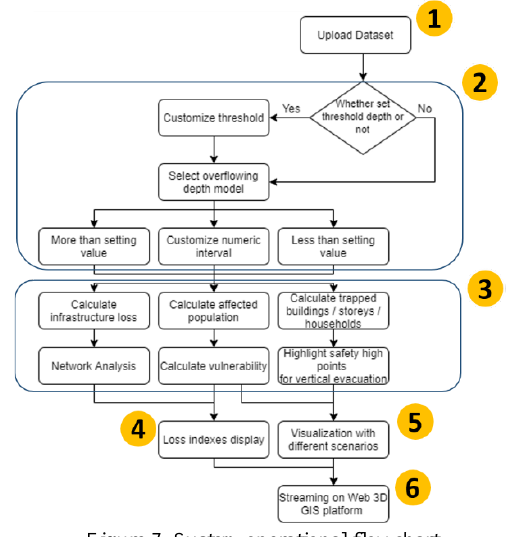
Figure 7. System operational